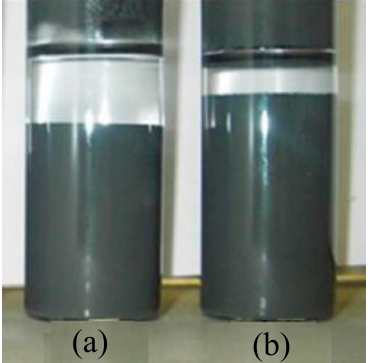
Figure 10. MR fluid samples ( a ) Sunflower oil blend-based ( b ) cottonseed oil blend-based.